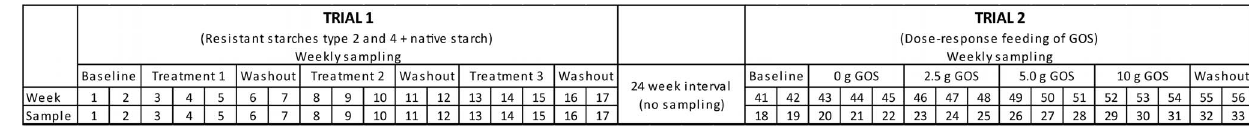
Figure 1. Experimental design. 33 (two subjects) and 32 (one subject) samples were collected in a 56-week time period from human subjects that participated in two dietary trials testing the effect of resistant starches and GOS on the fecal microbiota [31,32]. Fecal samples were collected weekly throughout both trials (17 in Trial 1 and 16 in trial 2), and the two trials were interspaced by a 24-week period without sampling.